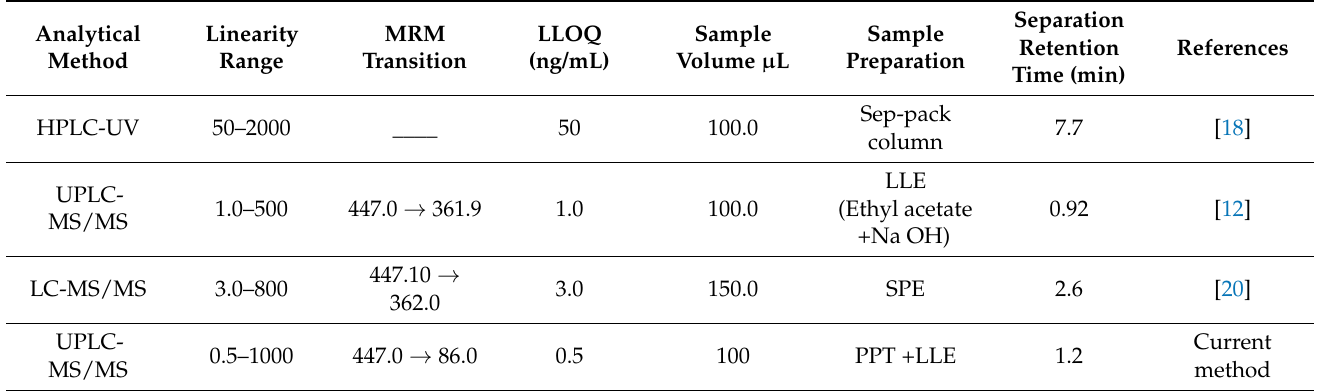
Table 5. Comparison of the proposed method with previous reported methods for the determination of ERDA in plasma